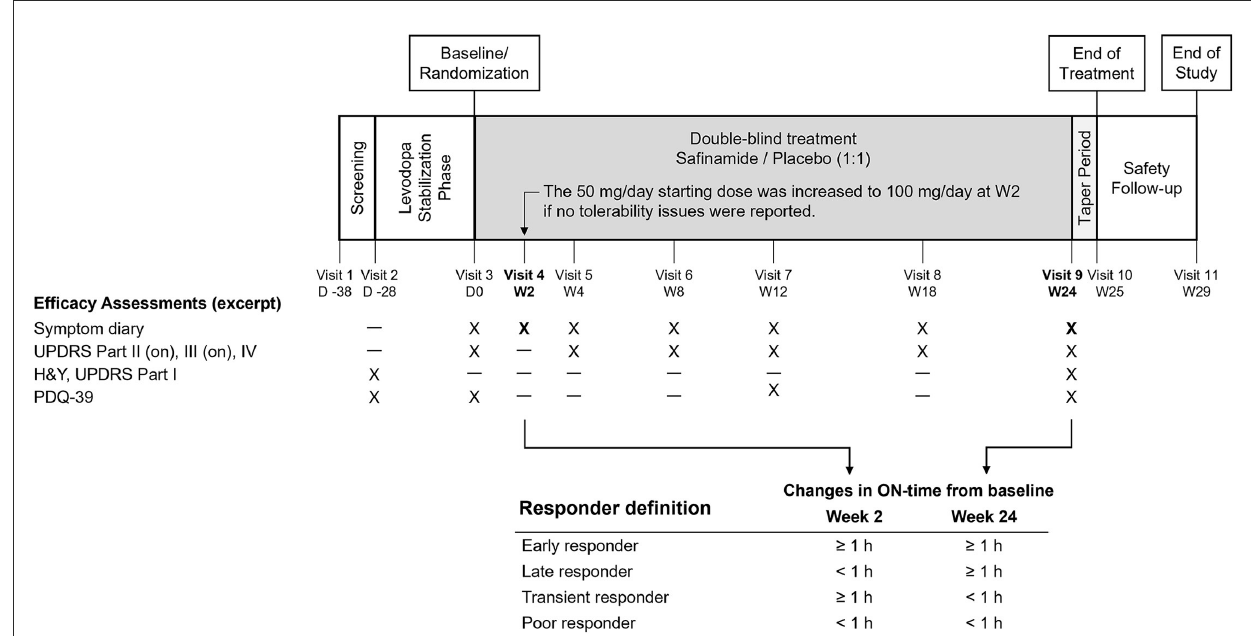
FIGURE1 Design of the SETTLE study and the responder definition in the present analysis. H&Y, Hoehn and Yahr staging, PDQ-39, 39-item Parkinson’s Disease Questionnaire; UPDRS, Unified Parkinson’s Disease Rating